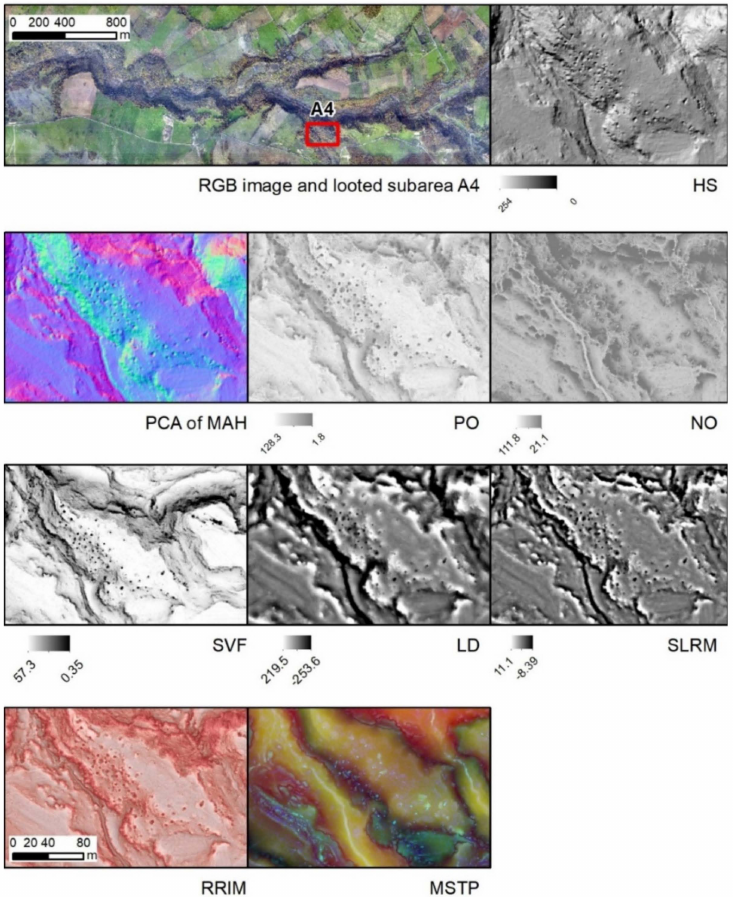
Figure 7. The subarea A4 found with VTs affected by looting. In the left-high corner, the localization of the A4 subarea is overlaid to the RGB image. In the other frames the different VT results are